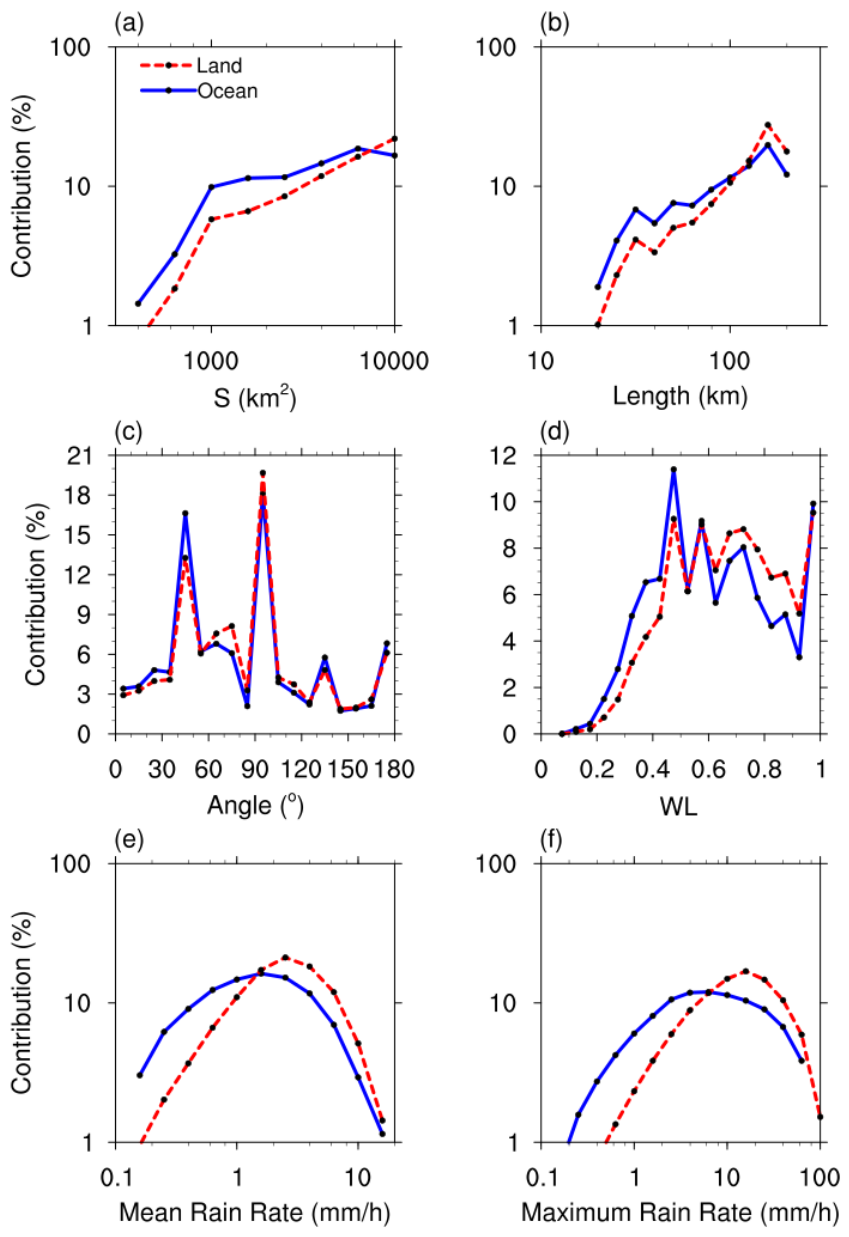
Figure 4. PDFs of the parameters of oceanic and continental rain clusters: ( a ) S , ( b ) length, ( c ) rotation angle, ( d ) WL , ( e ) mean rain rate and ( f ) maximum rain rate. The red dotted and blue solid lines represent continental and oceanic rain clusters,